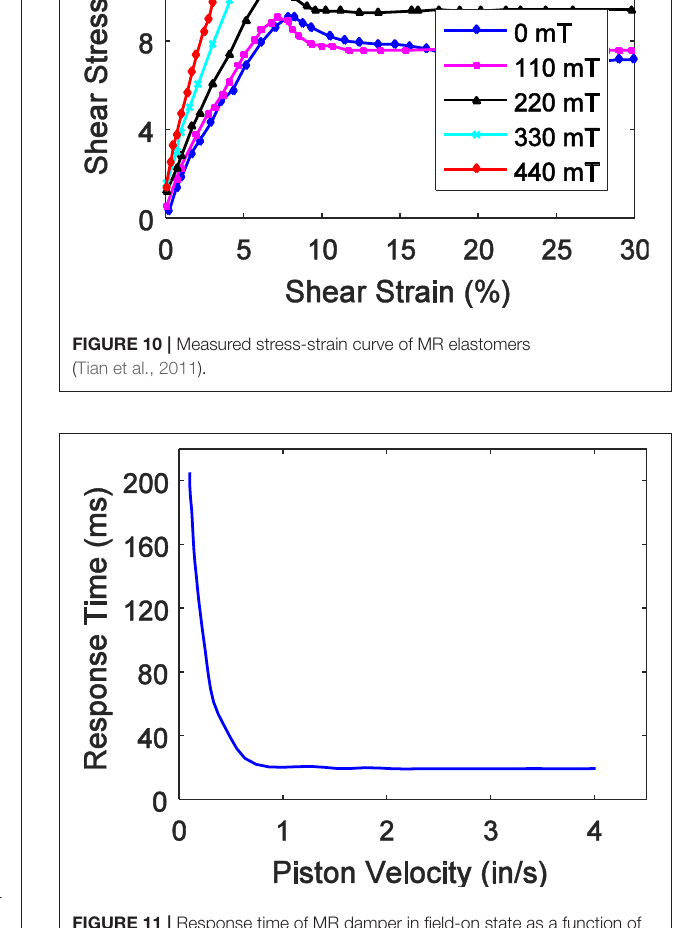
FIGURE 11 | Response time of MR damper in field-on state as a function of piston velocity (Koo et al.,